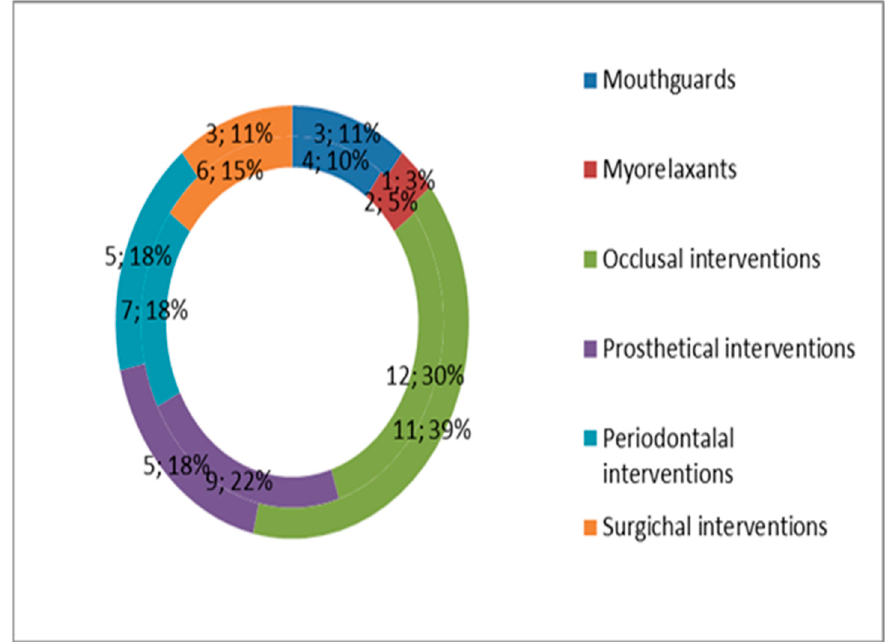
Figure 15. Distribution of rehabilitation treatments at dysfunctional syndrome—SDSS interferences.